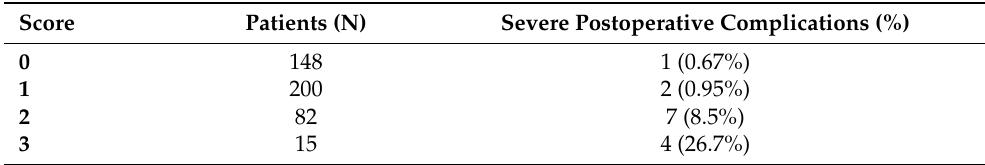
Table 6. Risk assessment